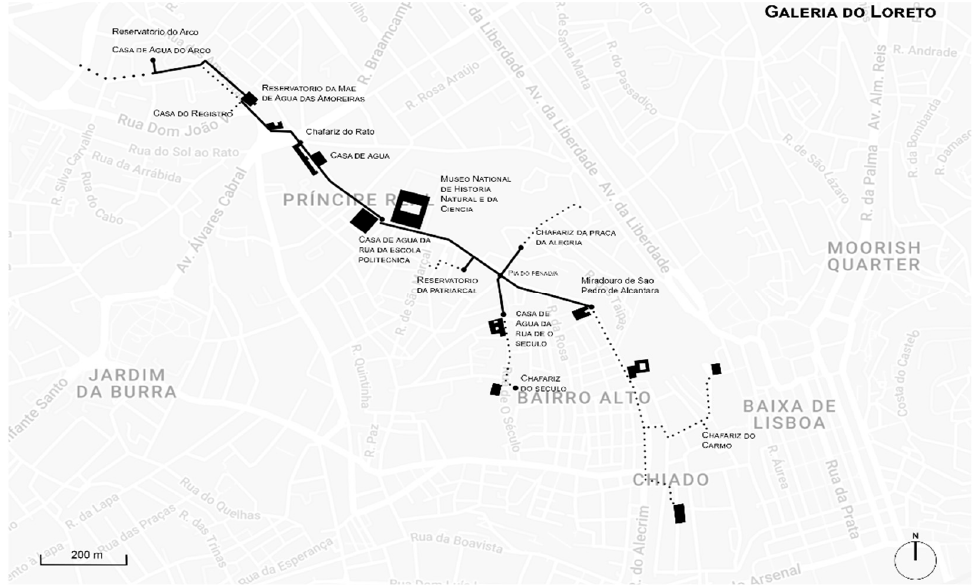
Figure 3. Galeria do Loreto, Lisbon (© L. Gorgoglione).